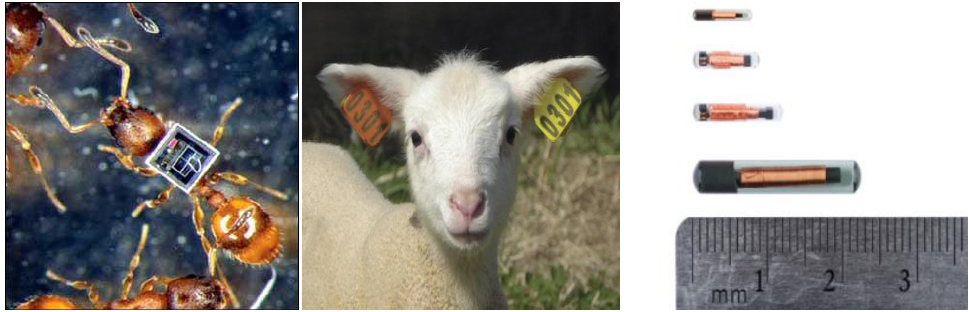
Figure 6. ( Left ) A radio tagged ant (Reproduced with permission from RFID Journal, 1 August 2009. Image, and copyright held, by, Nigel R. Franks) [107], ( Middle ) Passive RFID ear tags (Image provided by Premier1Supplies [108]), ( Right ) Passive RFID implants (Image provided by Biomark Inc.